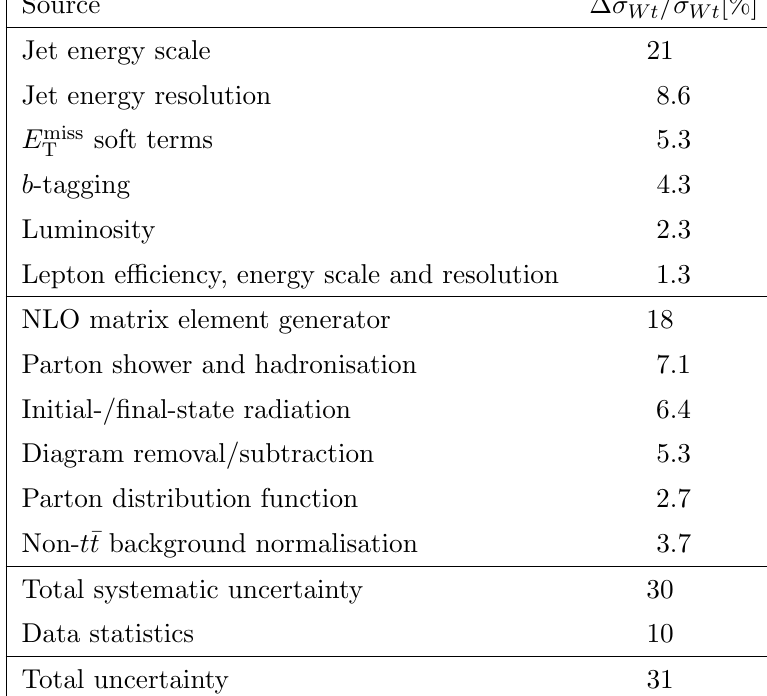
Relative uncertainties in the Wt cross-section. These are estimated by (cid:12)xing each uncertainty parameter to its post-(cid:12)t (cid:6) 1 (cid:27) uncertainties, re-(cid:12)tting, and assessing the change in the signal strength. Due to correlations between parameters, the individual uncertainty categories are not expected to add up to the total systematic uncertainty. The statistical uncertainty is evaluated by (cid:12)tting without any nuisance parameters corresponding to systematic uncertainties in the (cid:12)t, and the total systematic uncertainty is evaluated by subtracting the statistical uncertainty from the total uncertainty in